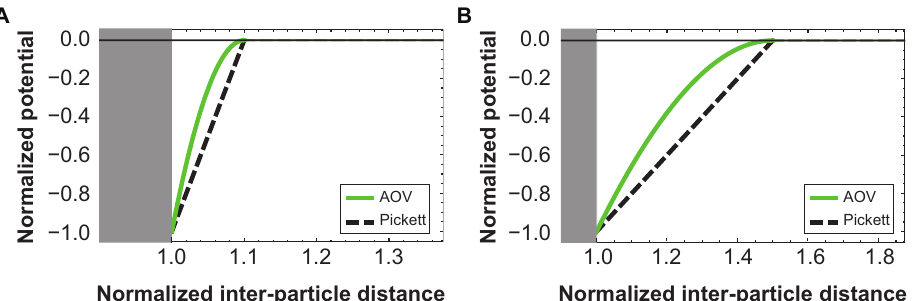
Figure 2. Comparison of potentials. AOV depletion potential and the potential as given in Equation (1) (denoted here as Pickett potential) normalized to the contact potential as a function of normalized inter-particle distance for ( A ) q = 0.1 and ( B ) q = 0.5. For small q, the two potentials are fairly